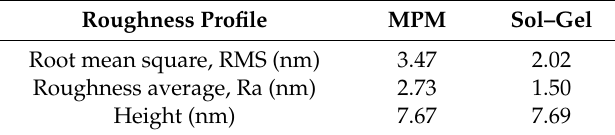
Figure 3. Atomic force microscopy (AFM) image (1 µ m × 1 µ m) of ZnO thin films prepared via ( a ) MPM and ( b ) sol–gel techniques. Table 2. Surface roughness of MPM- and sol–gel-derived ZnO thin films.